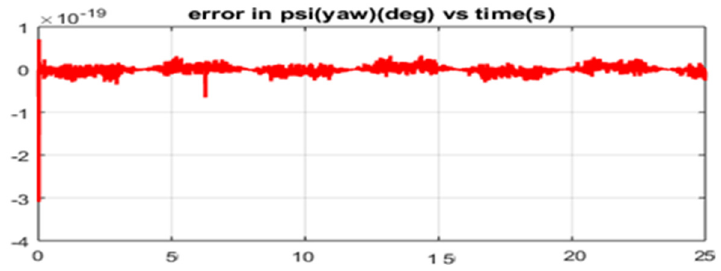
Figure 22. Yaw error rates while maneuvering using MFSDF-SMC.